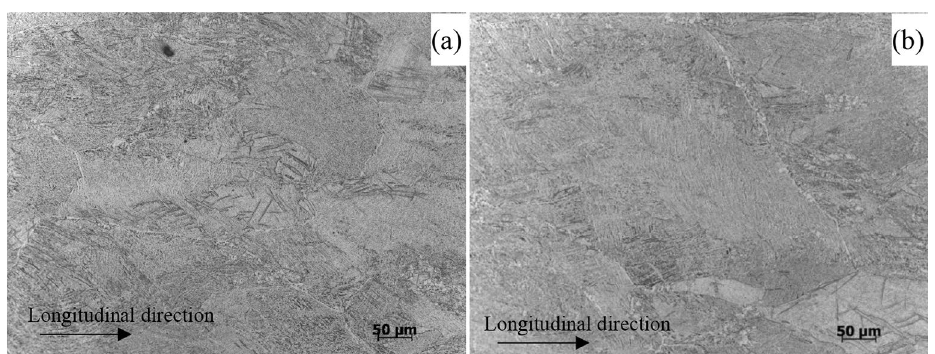
Figure 17. Microstructures of titanium alloy samples: ( a ) Ti-6Al-4V-0.11Ru and ( b )